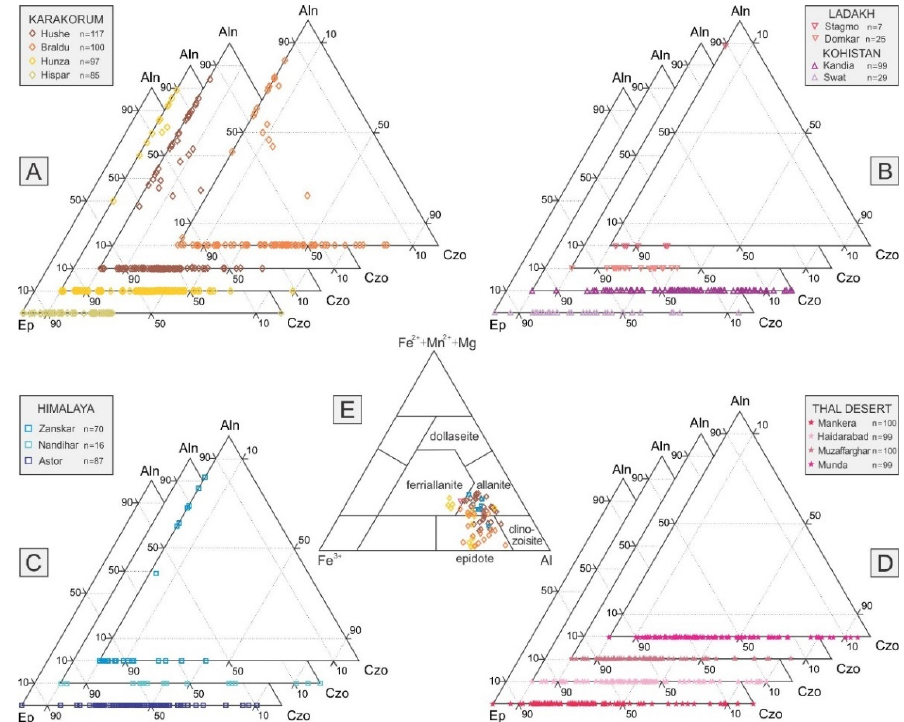
Figure 5. Chemical composition of detrital epidote-group minerals in river sands of northern Pakistan and in the Thal Desert. ( A – D ) The proportion of clinozoisite, allanite, and epidote were calculated as Al (atoms per formula unit (a.p.f.u.)) – 2, if Al (a.p.f.u.) > 2 (otherwise the proportion was taken as zero), as rare earth elements (REE) (a.p.f.u.), and as 1-allanite-clinozoisite, respectively [126]. Aln: allanite; Ep: epidote; Czo: clinozoisite. ( E ) Classification of REE-bearing epidote grains after Kartashov